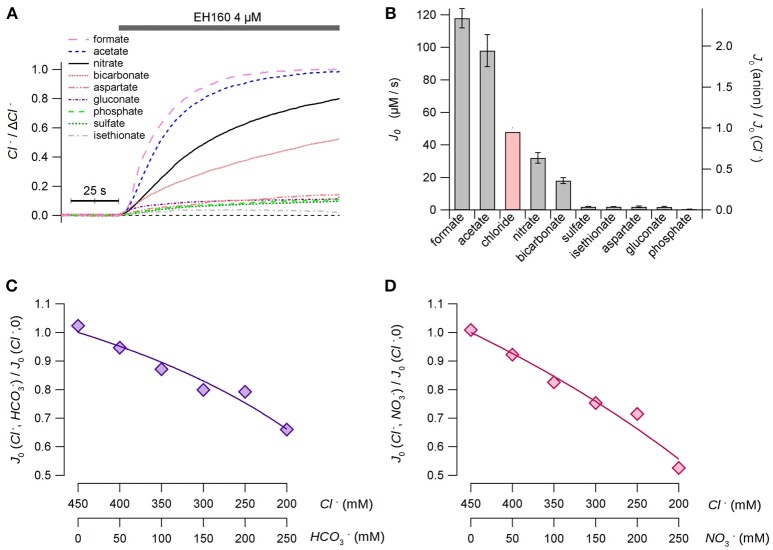
Permeability of the anionophore EH160 to different anions. (A) Time course of the external concentration of chloride measured in LUV with 450 mM internal chloride and variable external iso-osmotic anions, as indicated in the figure. The application of the anionophore is indicated in the upper bar. Data was normalized by the maximum anion change, ΔCl−. (B) The initial chloride efflux, J0, measured for different external anions. The red bar is the estimated chloride efflux in the presence of external chloride, calculated from the apparent dissociation constants of the anionophore for chloride, bicarbonate and nitrate estimates in the competition experiments. Data represent the average (± s.e.m.) of, at least, three different measurements. Panels (C,D) show the results of the bicarbonate/chloride and nitrate/chloride competition experiments, respectively. The concentrations of anions are shown in the bottom axes of the figures. The continuous lines represent the best fit of data with Equation (4).